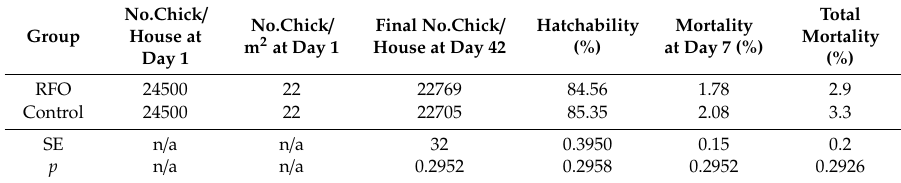
Table 1. Mortality of chickens and housing condition.